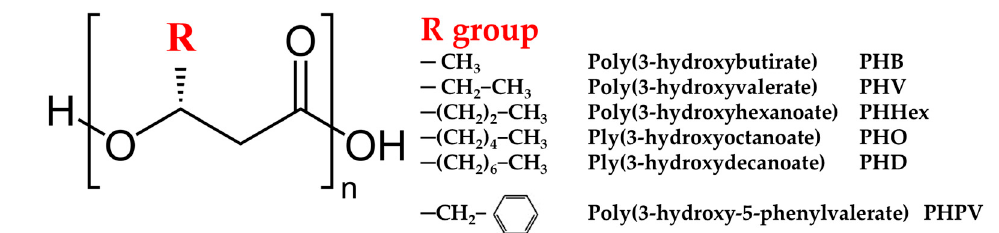
Figure 24. Structure of polyhydroxyalkanoate (PHA) pristine bionanomolecules.